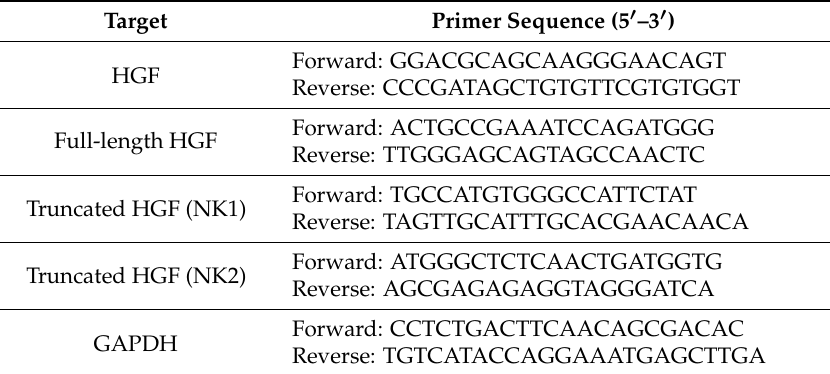
Table 1. Forward and reverse primer sequences used for